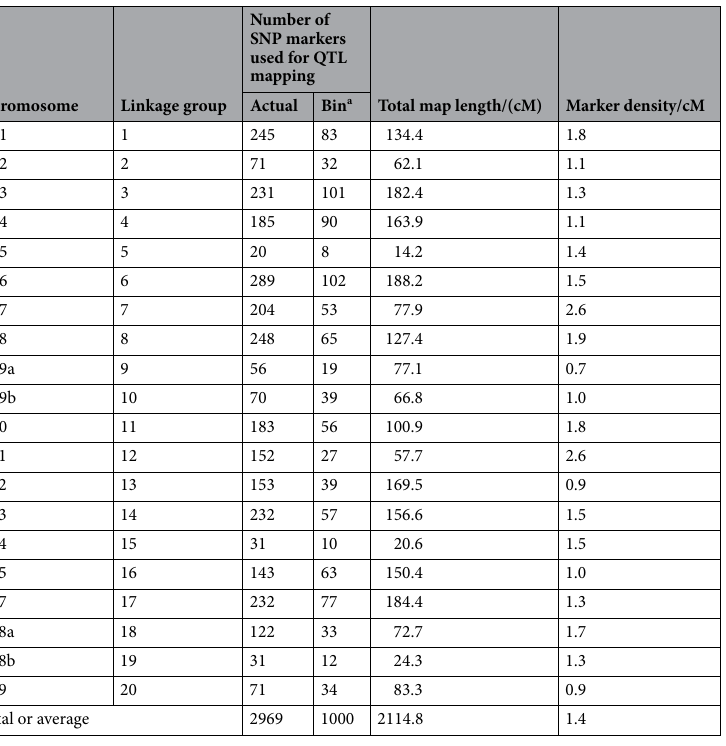
Table 3. The distribution of 2969 ‘Mendelian’ and ‘distorted’ SNP markers on 20 linkage groups representing 18 of the 19 chromosomes used to map QTL for clubroot resistance in doubled haploid lines derived from the Brassica napus cv. ‘Tosca’. a Multiple markers that mapped to the same position on the linkage map were put in the same